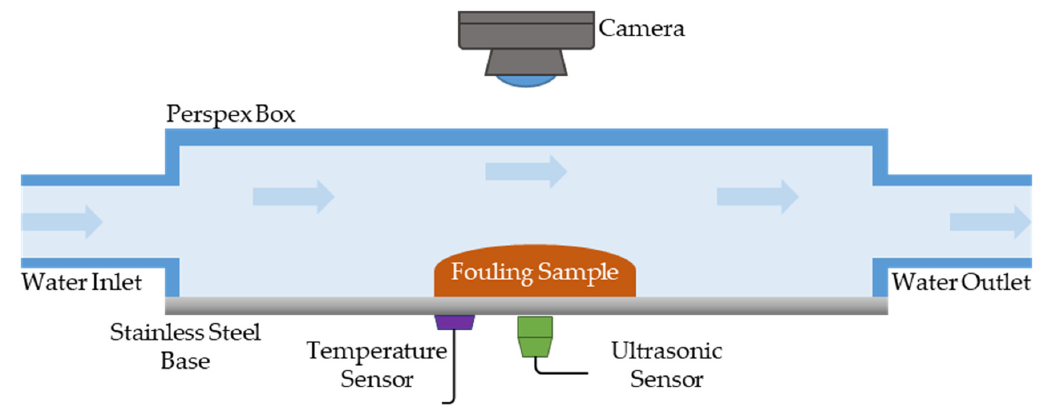
Figure 1. Experimental setup with sensors.